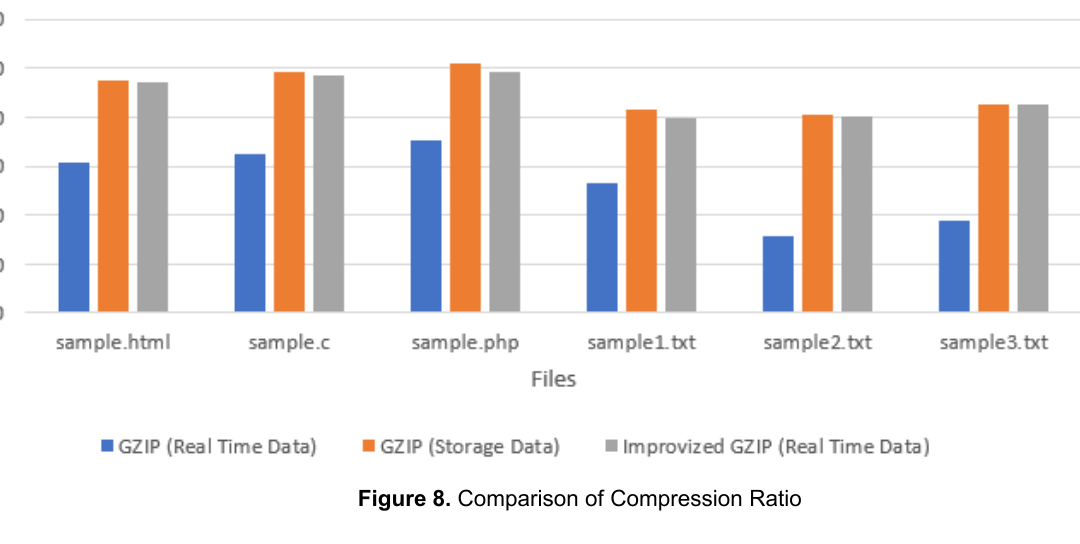
Figure 8. Comparison of Compression Ratio